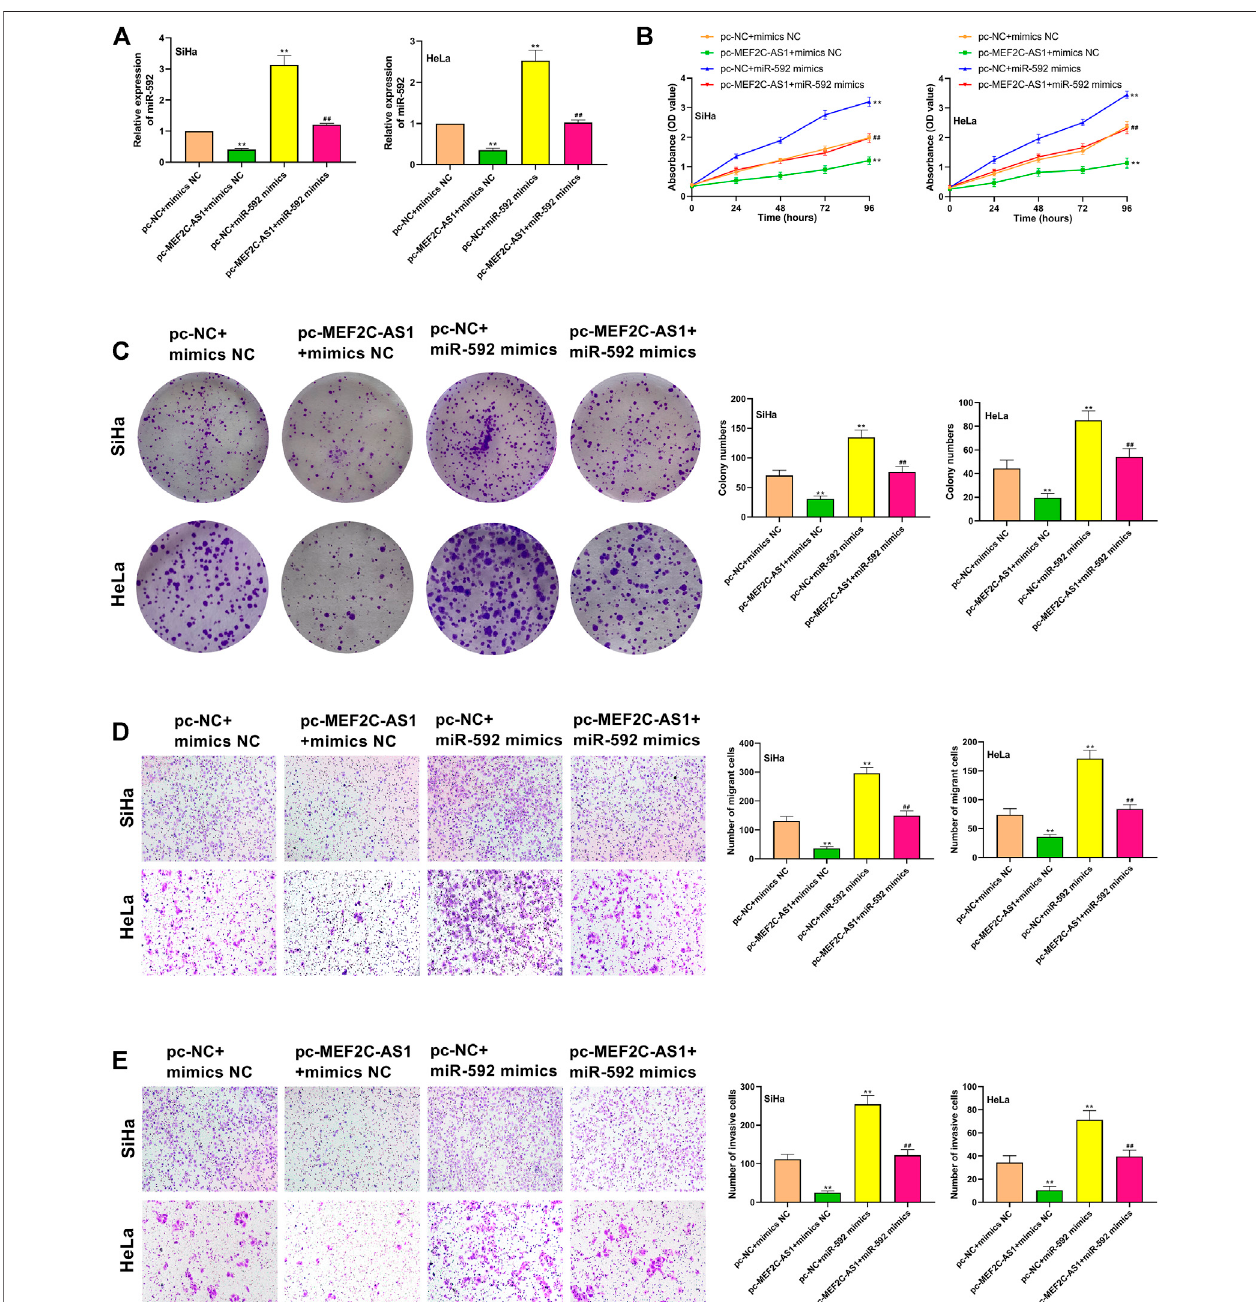
FIGURE 4 | Overexpression of lncRNA MEF2C-AS1 inhibited proliferation, migration and invasion of CC cells by regulating miR-592. (A) Expression of miR-592 after transfection of pc-MEF2C-AS1, miR-592 mimics or pc-MEF2C-AS1 + miR-592 mimics was detected by qRT-PCR; (B) The proliferation ability of SiHa and HeLa after transfected with pc-MEF2C-AS1, miR-592 mimics or pc-MEF2C-AS1 + miR-592 mimics was measured by CCK-8; (C) The colony formation ability of SiHa and HeLa after transfected with pc-MEF2C-AS1, miR-592 mimics or pc-MEF2C-AS1 + miR-592 mimics was measured by colony formation assay; (D) After transfected with pc-MEF2C-AS1, miR-592 mimics or pc-MEF2C-AS1 + miR-592 mimics, transwell assay was conducted to detect the migration ability of SiHa and HeLa; (E) Aftertransfectedwithpc-MEF2C-AS1,miR-592mimicsorpc-MEF2C-AS1+miR-592mimics,transwellassaywasperformedtomeasuretheinvasionofSiHa and HeLa. Measurementdata were expressed as mean ± standard deviation. The cell experiment isrepeated three times independently. ** p < 0.01, compared with pc- NC + mimics NC group; ## p < 0.01, compared with pc-MEF2C-AS1 + mimics NC or pc-NC + miR-592 mimics group (A – E) .